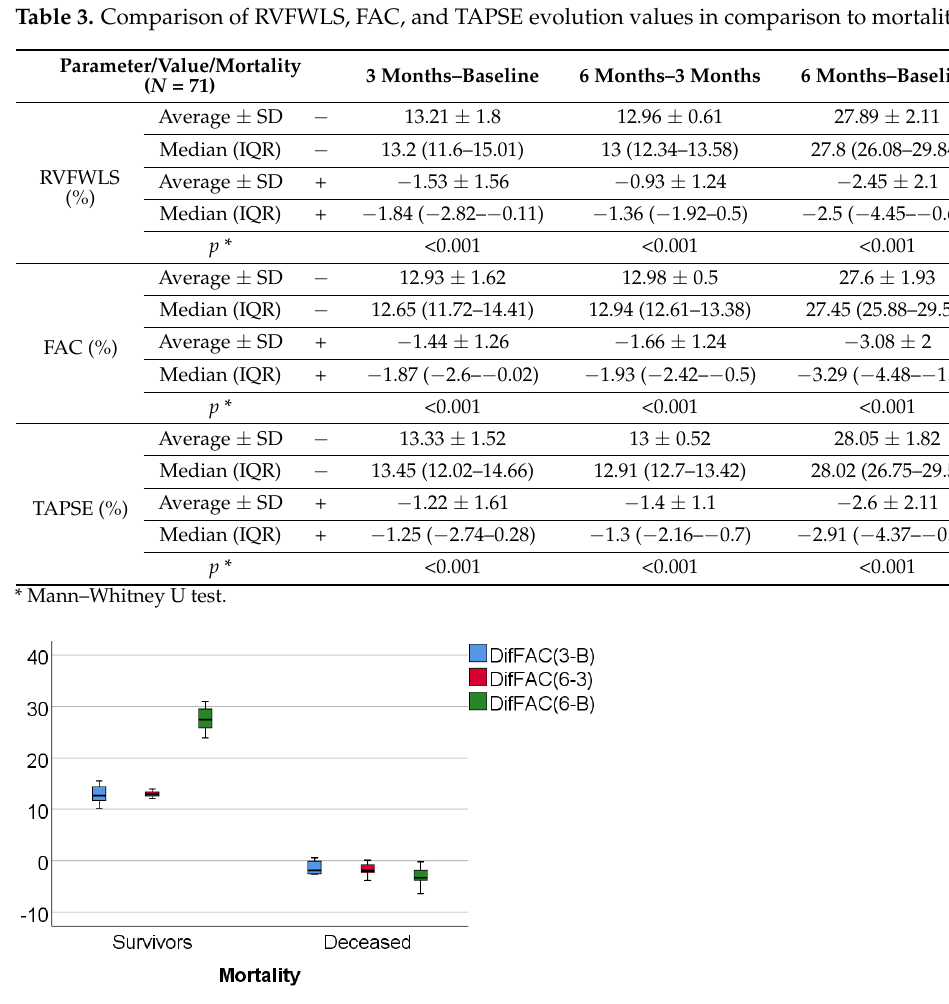
Figure 5. Box-plot representation of FAC evolution in comparison with mortality.